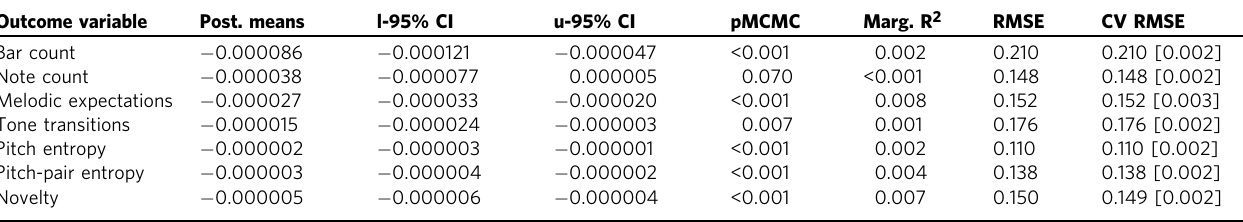
Table 2 Results of tune-level models predicting measures of tune complexity from popularity (N tunebook adds, n = 9378). Outcome variable Post. means